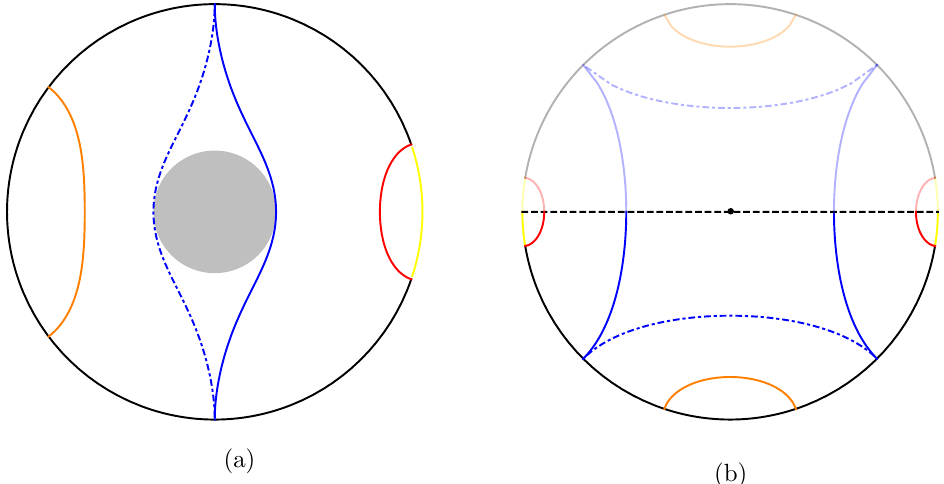
Figure 2. A constant time slice of conical AdS 3 with (cid:11) = 1 = 2 is shown. The boundary is pulled to a (cid:12)nite value by using the radial coordinate, (cid:26) = arctan r . The entanglement shadow is shown in gray. A few representative HRT surfaces are shown in orange, blue and red on the fundamental domain in (a). The same geodesics are shown on the covering space (AdS 3 ) in (b) together with their images. The fundamental domain is obtained by identifying points under a rotation by (cid:25)